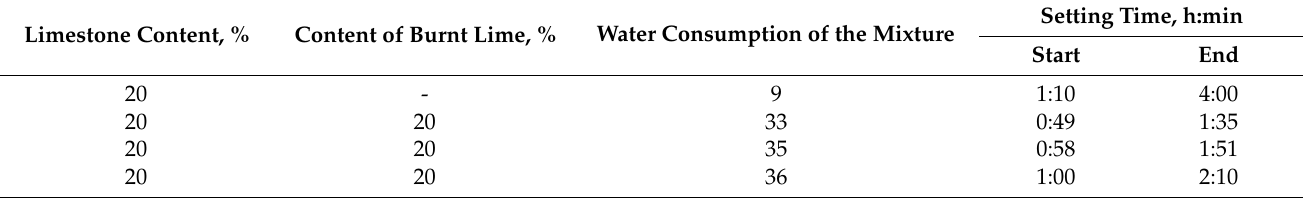
Table 3. Influence of hydrated lime on setting